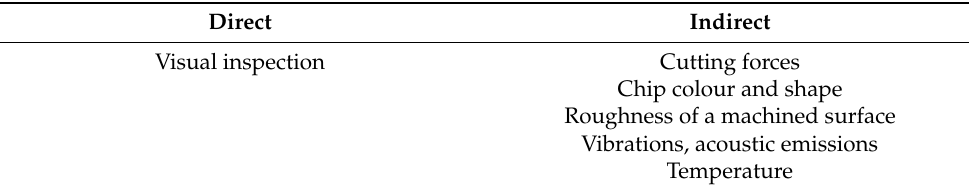
Table 1. Methods for determining the level of a cutting tool’s